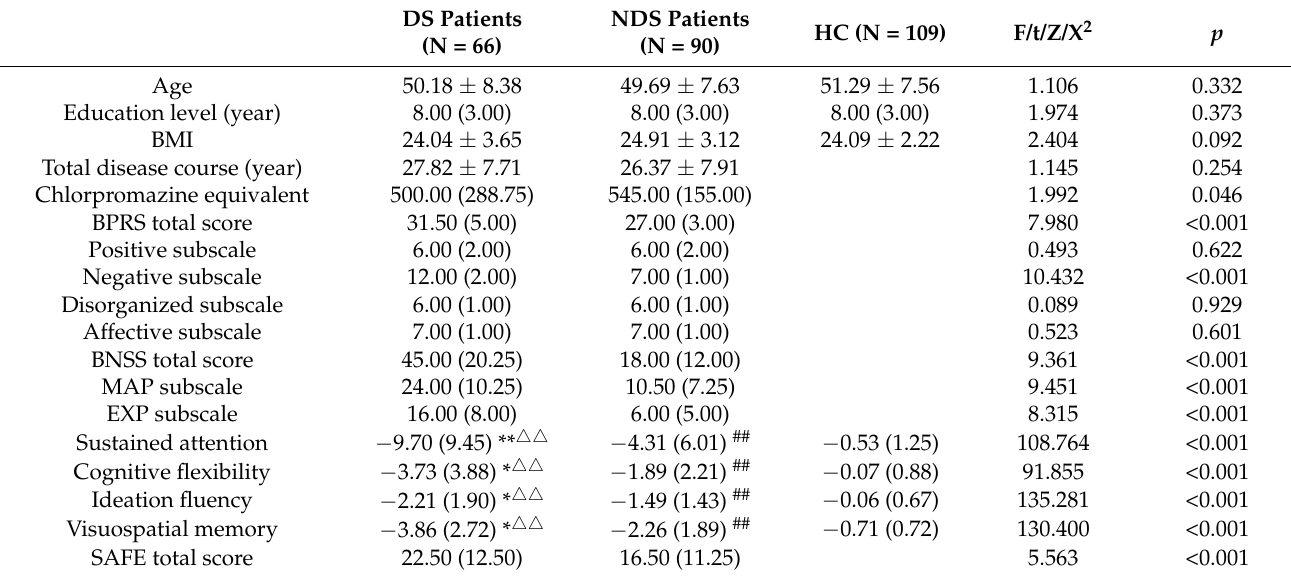
Table 1. Comparisons of demographic and clinical characteristics among DS, non-DS schizophrenia patients, and HC